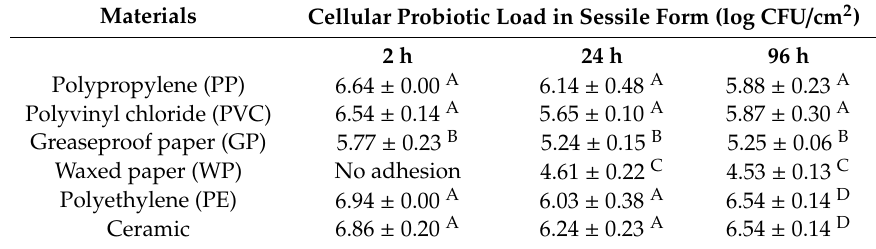
Table 3. Cellular probiotic load in sessile form (log CFU / cm 2 ) observed on common packaging materials used in the food industry and on